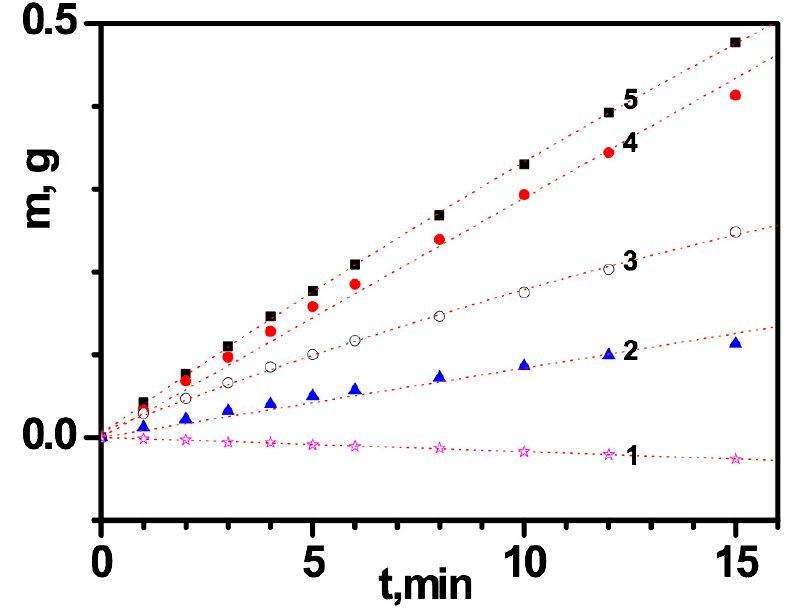
Figure 7. The loss weight of the sample as a function of time during free evaporation from the Petri dish with a diameter d = 9 cm for the system FA:ethanol with mass ratio: ( 1 ) 10:0.5, ( 2 ) 10:1, ( 3 ) 10:1.5, ( 4 ) 10:3, ( 5 ) 10:5. Temperature T = 22 ◦ C, relative humidity H =